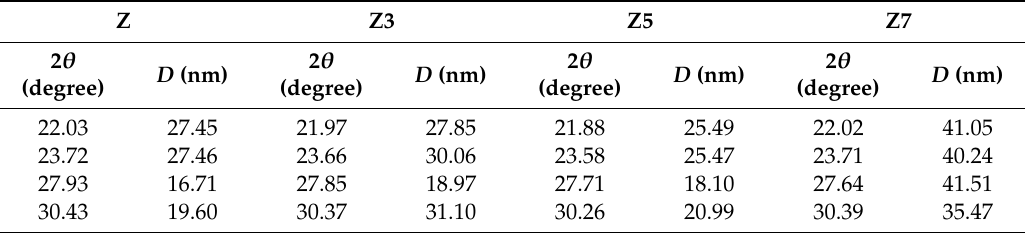
Table 5. Crystal grain size of Z, Z3, Z5, and Z7 catalysts.